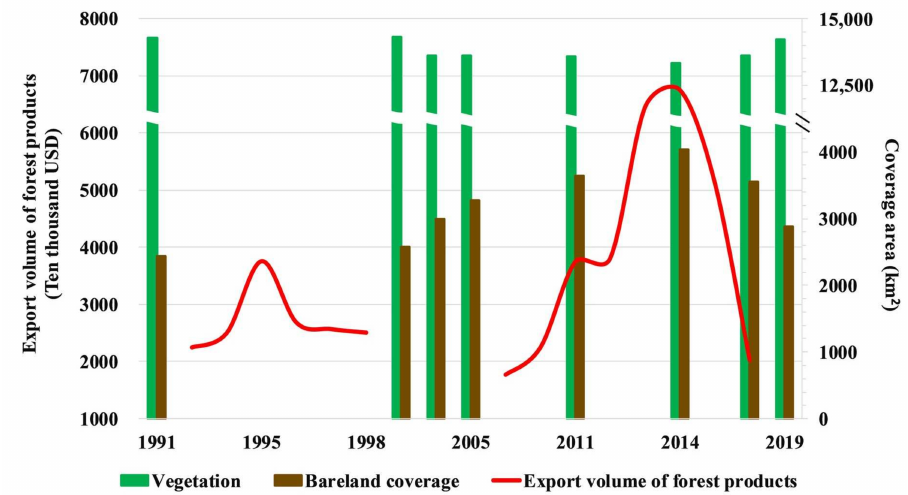
Figure 8. Changes in vegetation and bare land during 1991–2019 (data from Table 2), and Fiji’s forest product exports (data from the literature and Food and Agriculture Organization of the United Nations (FAO) [52,53]).